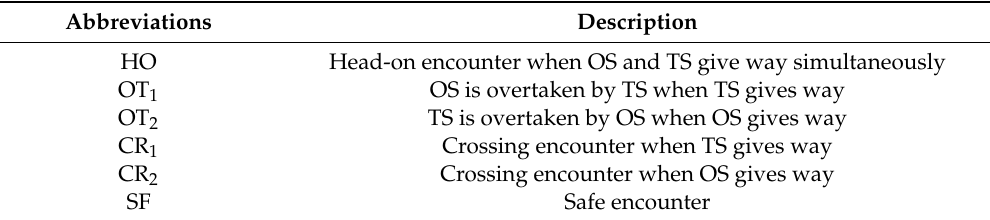
Table 2. The quantified criteria for specific encounter